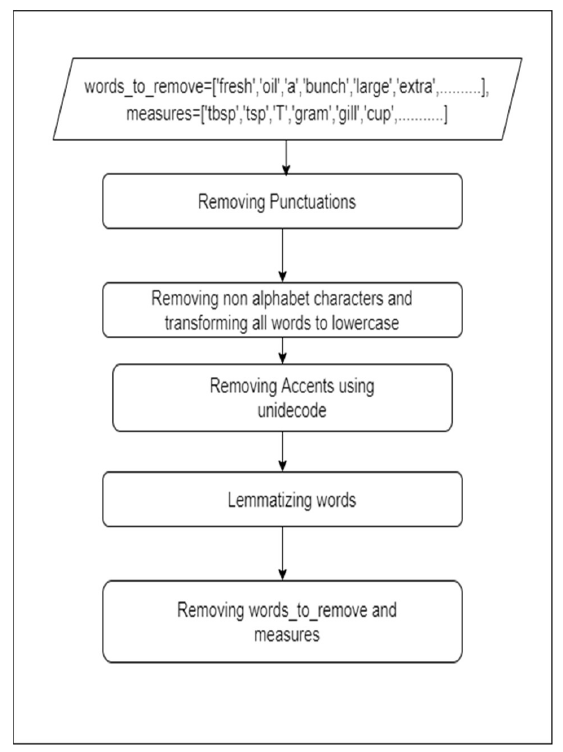
Fig. 2. Flowchart of Preprocessing Method.